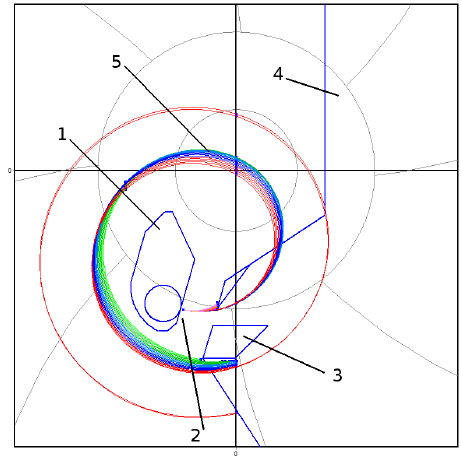
Figure 5. Planar view showing the shifted extraction slit (2) of the ion source (1) with respect to the puller (3) on the dee (4). A part of the beam (5) is stopped on the puller during the first orbit. Simulated in Durycnm4 [11].